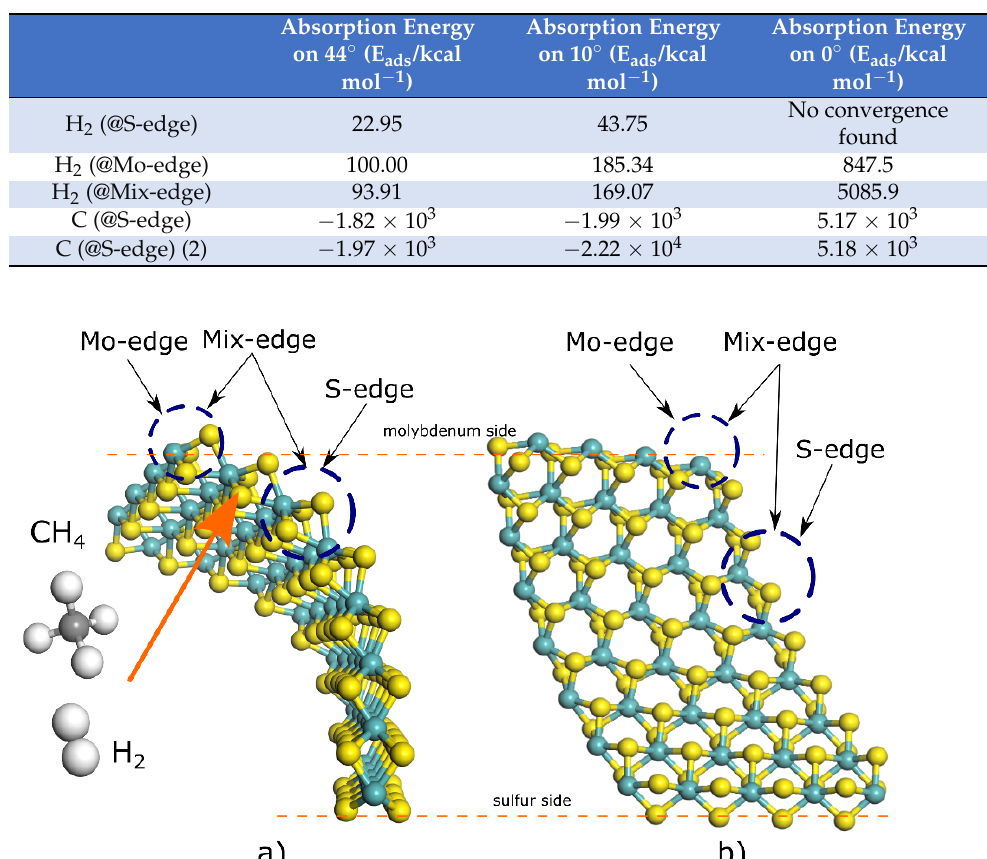
Table 3. Comparison of computed adsorption energy of hydrogen (H 2 ) on S-edge, S-Mo-edge, and Mix-edge sites between 2H-MoS 2 slabs with 10 ◦ and 44 ◦ and 0 ◦ bending.